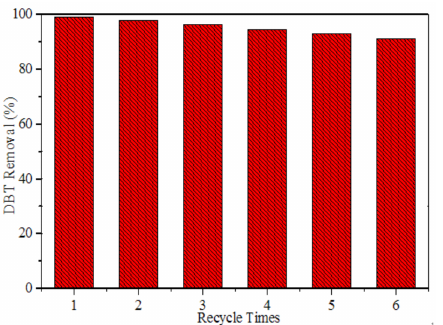
Figure 10. Effects of repeated times of the catalyst on the removal rate of